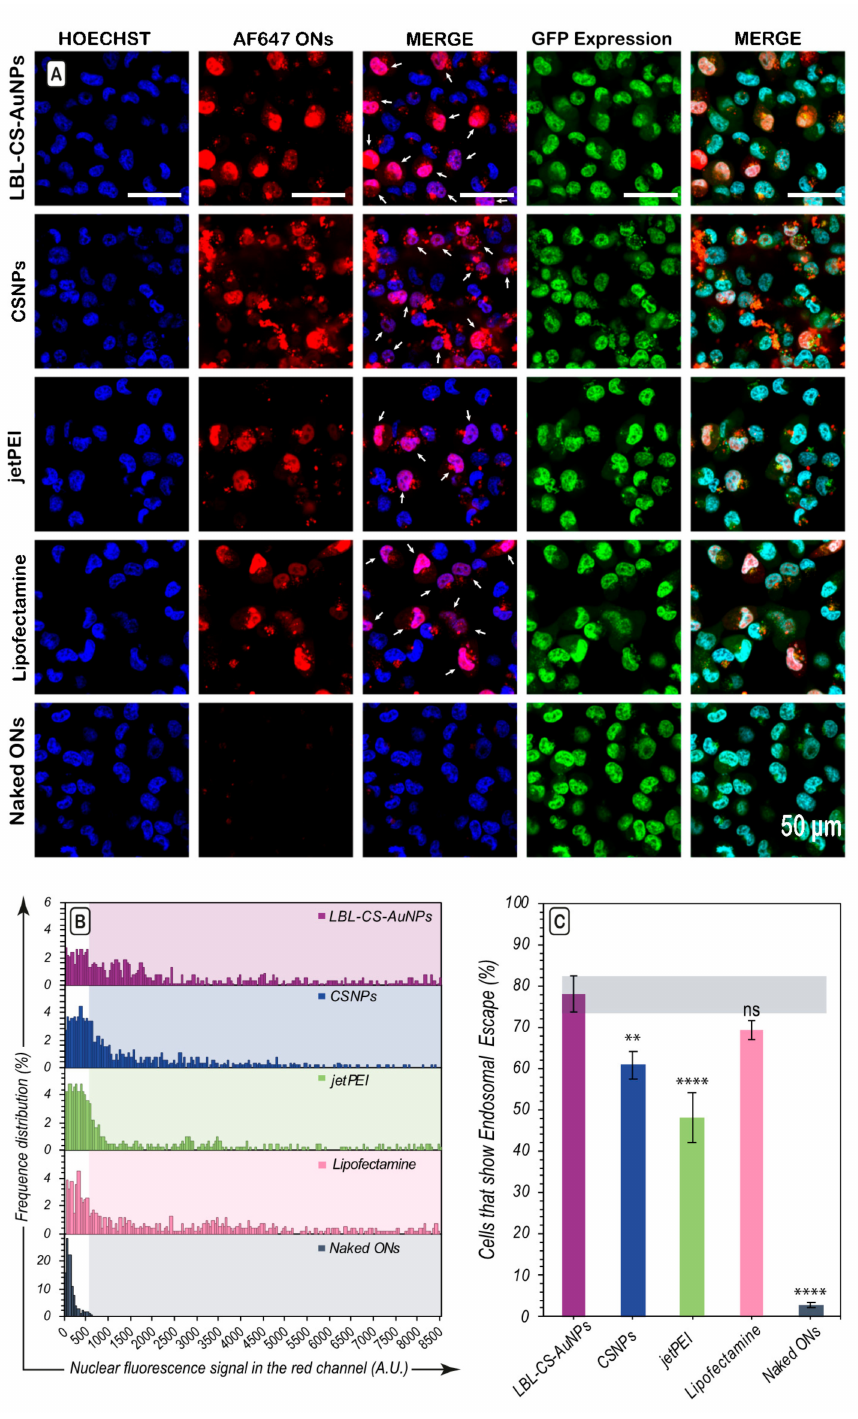
Figure 7. Evaluating the role of endosomal escape. ( A ) Representative confocal images 24 h after incubation with AF647-ON loaded carriers in the H1299-eGFP cell line. Hoechst nuclei can be seen in blue, while cells in which endosomal escape occurred show nuclear fluorescence in the red channel due to the release of AF647 ONs from the endosome to the cytoplasm, which finally accumulate in the nuclei (white arrows in 3rd column). The scale bars correspond to 50 µ m. ( B ) Histograms of the red fluorescent intensity of cell nuclei for the different nanocarriers. ( C ) The percentage of cells with red nuclei calculated by quantification of at least 500 nuclei. Data are represented as mean ± the standard error of the mean for a minimum of three independent experiments. Statistical significance, with respect to LBL-CS-AuNPs, is indicated when appropriate (ns = not significant p > 0.05, ** p ≤ 0.01, **** p ≤